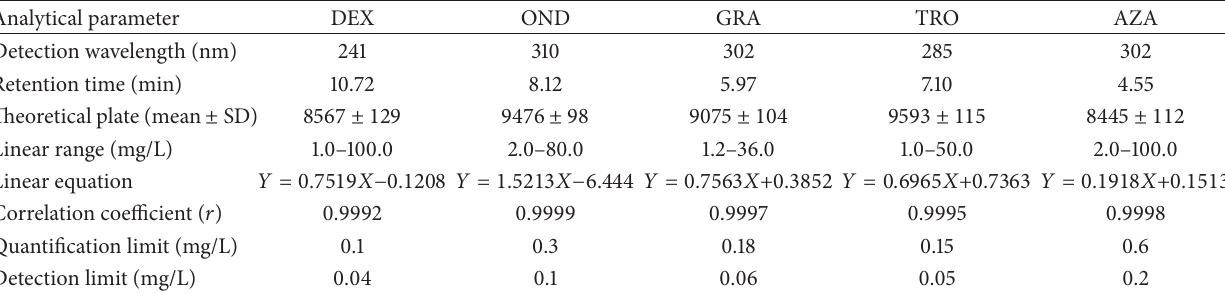
Table 1: System suitability parameters for DEX, OND, GRA, TRO, and AZA.